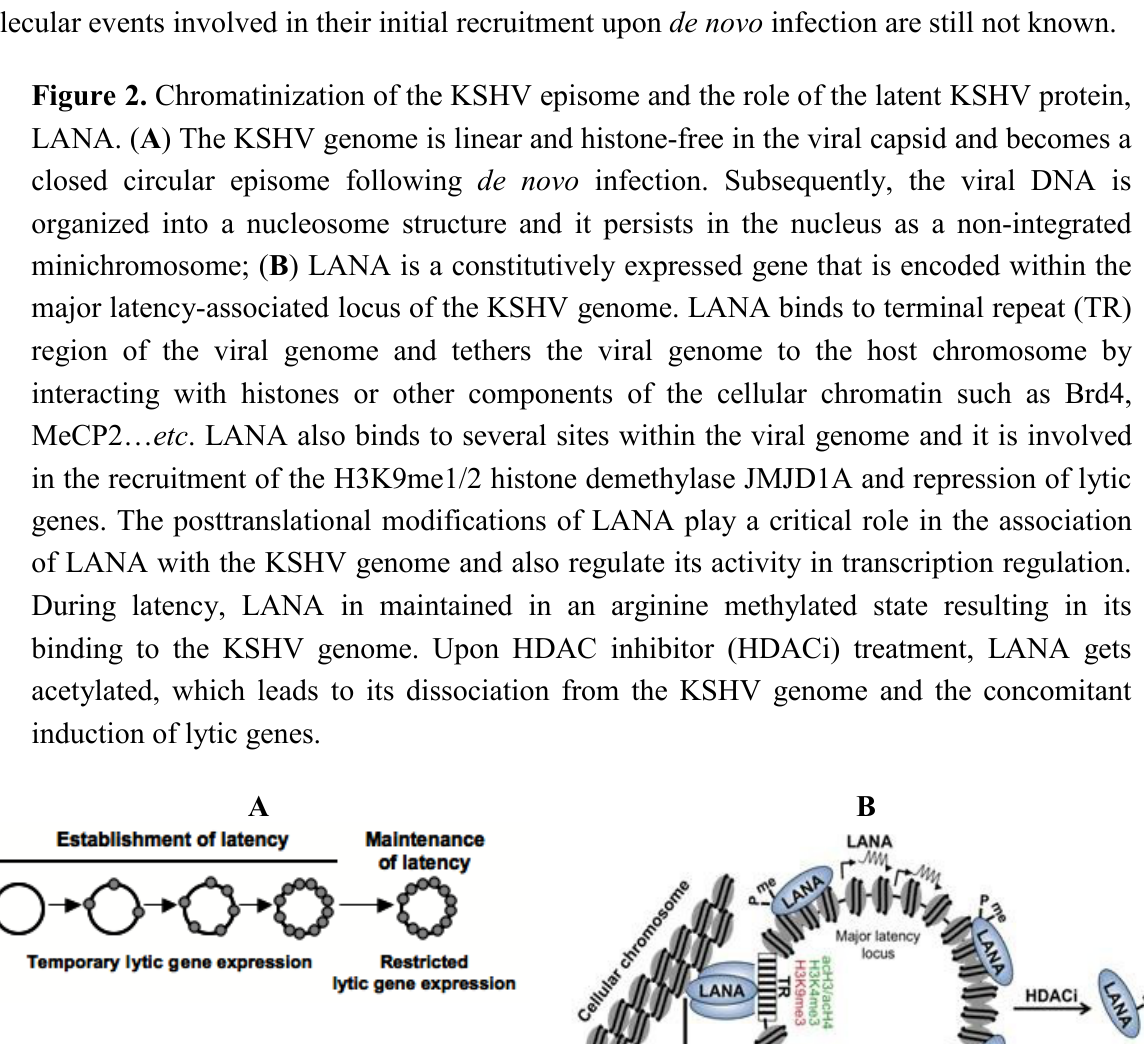
Figure 2. Chromatinization of the KSHV episome and the role of the latent KSHV